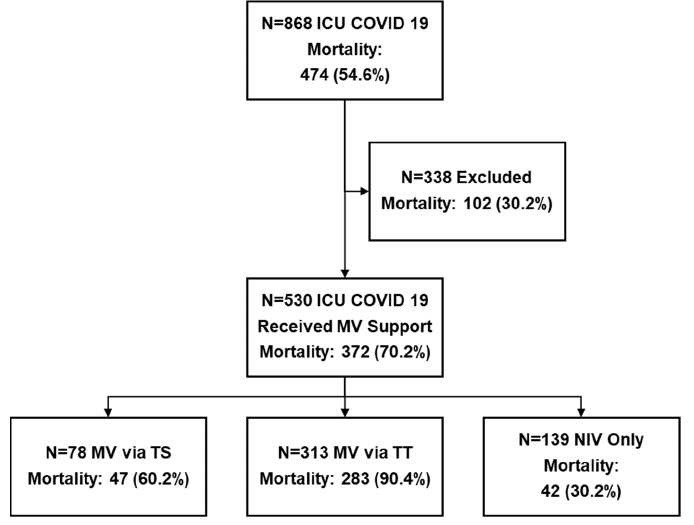
Figure 1. Patients’ inclusion flow. Abbreviations: COVID-19—coronavirus disease 2019; ICU—intensive care unit; MV—mechanical ventilations; TS—tracheostomy; TT—tracheal tube.